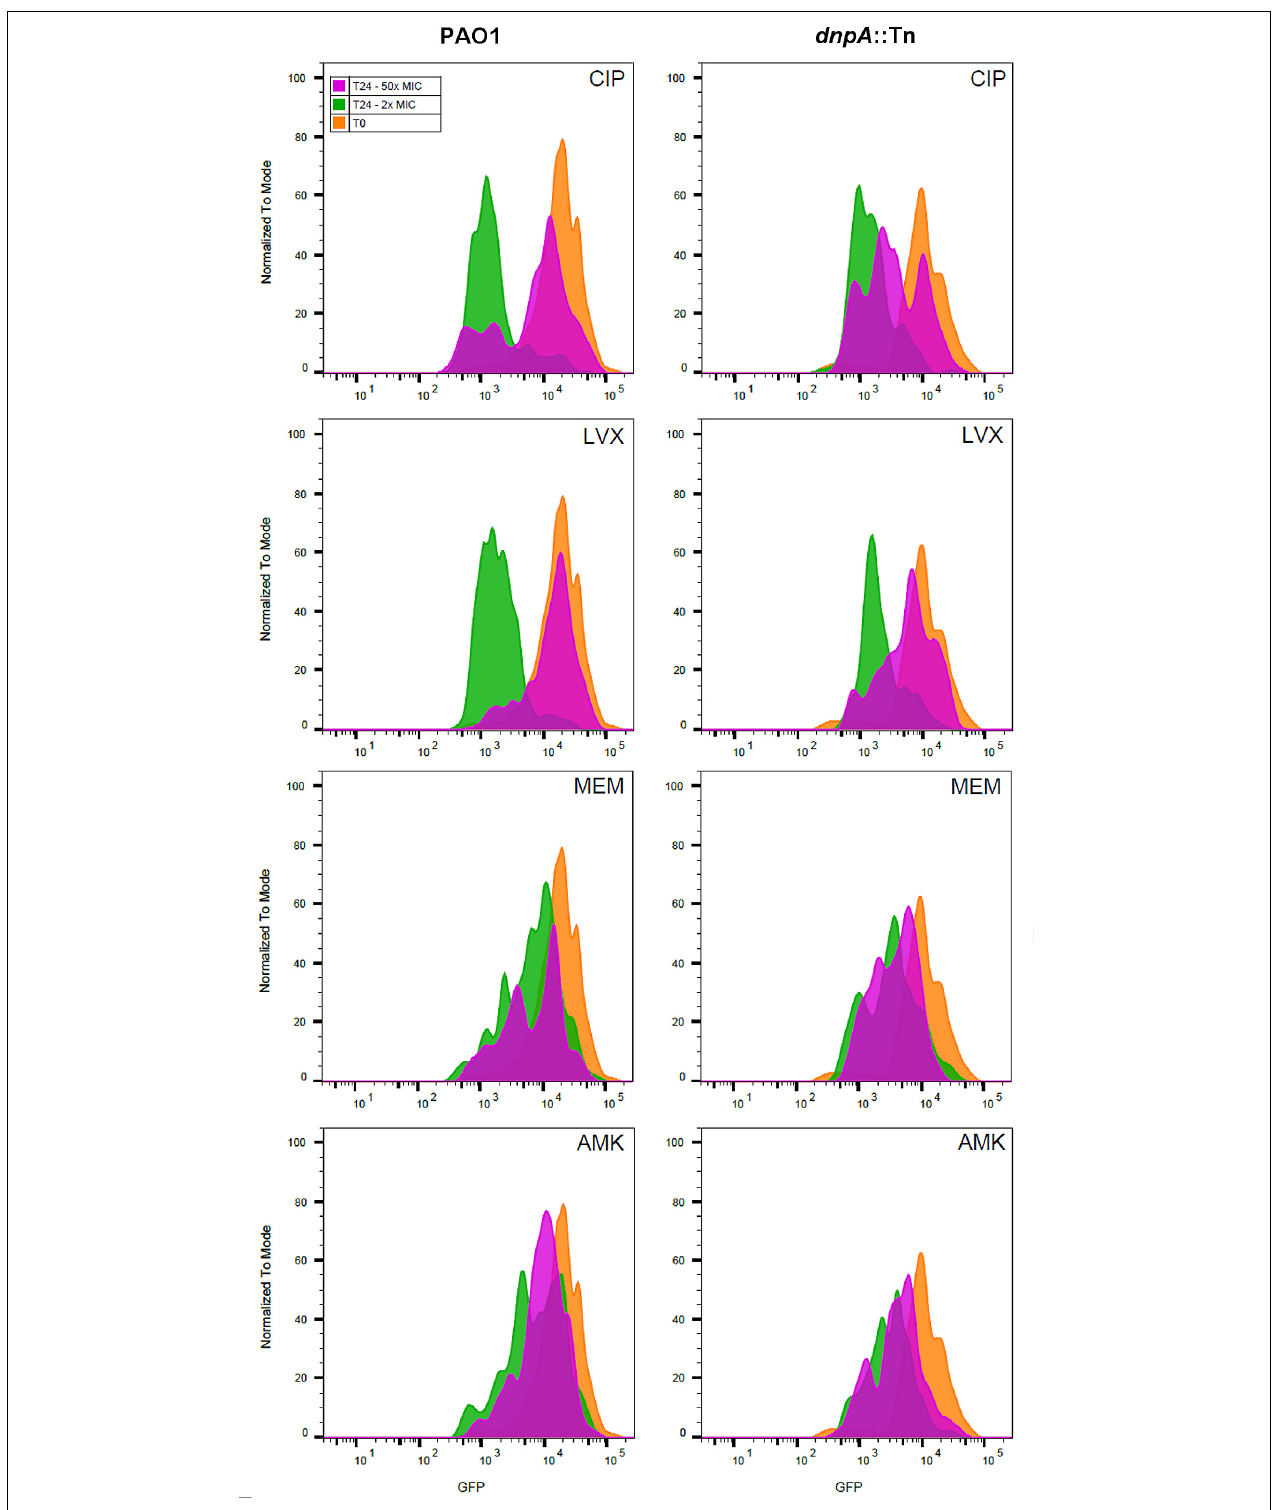
FIGURE 3 | Fluorescence dilution experiment performed on intraphagocytic P. aeruginosa strains expressing GFP. The histograms show the number of events (normalized to mode) as a function of the intensity in GFP signal. Infected monocytes were harvested after phagocytosis (T0, orange histogram) or exposed during 24 h (T24) to 2x (green histograms), or 50x (pink histograms) MIC of antibiotics. Bacteria were harvested after lysing the THP-1 monocytes with H 2 O. At least 2,000 events were measured for each sample. CIP, ciprofloxacin; LVX, levofloxacin, MEM, meropenem, AMK, amikacin.